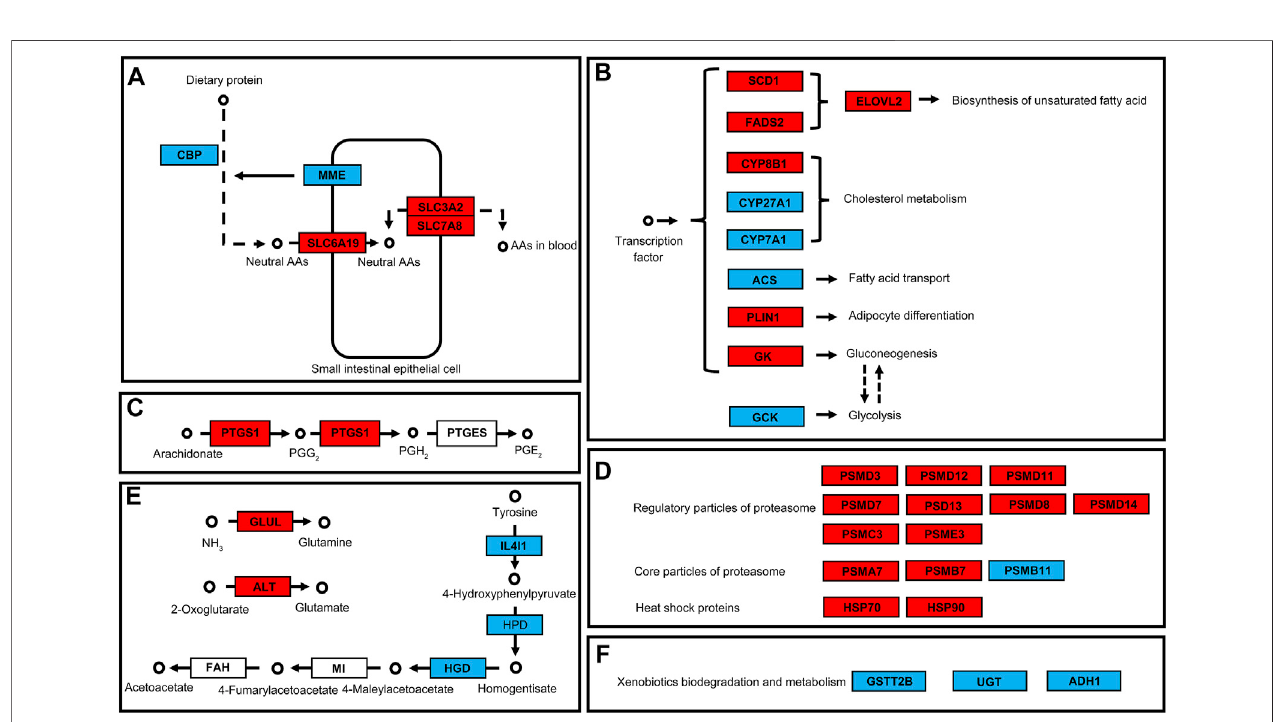
FIGURE 5 | Effects of polystyrene nanoplastics exposure on the key differentially expressed genes in the pathways of the Ietalurus punetaus larvae. (A) protein digestionand absorption. (B) PPARpathway and downstreamgenes. (C) biosynthesisofprostaglandins. (D) changesin genesrelated toproteasomesand heatshock proteins. (E) biosynthesis of speci fi camino acids. (F) changes inexpression ofseveralgenesinvolved in xenobiotics metabolism. Up-regulated genesare markedin red and down-regulated genes are marked in blue.